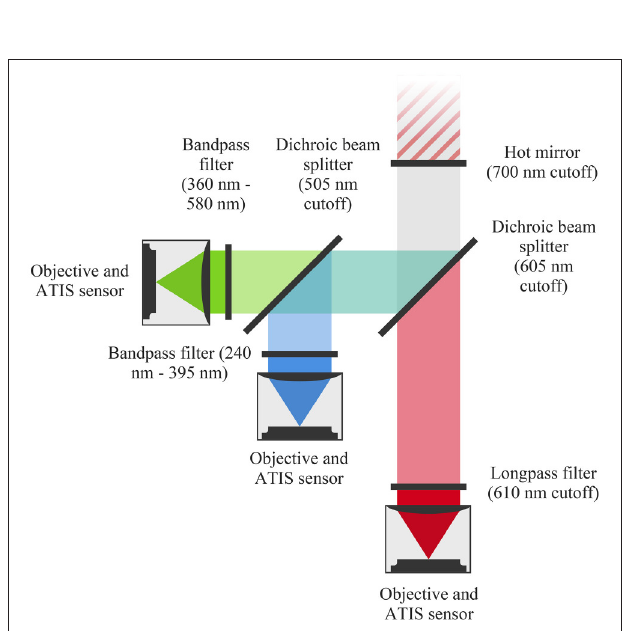
FIGURE 3 | Our three-chip event-based camera uses dichroic filters to split the light beam and ATIS cameras to record the scene as events. We use an objective for each camera instead of a single one in order to reduce the flange distance (constrained by the sensors’ size).